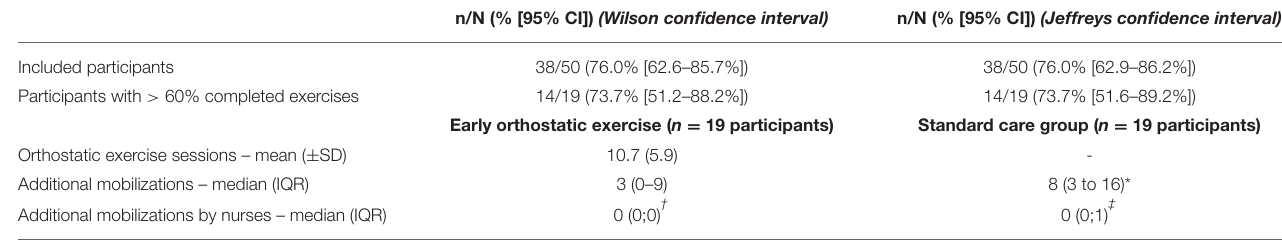
TABLE 2 | Feasibility outcome.